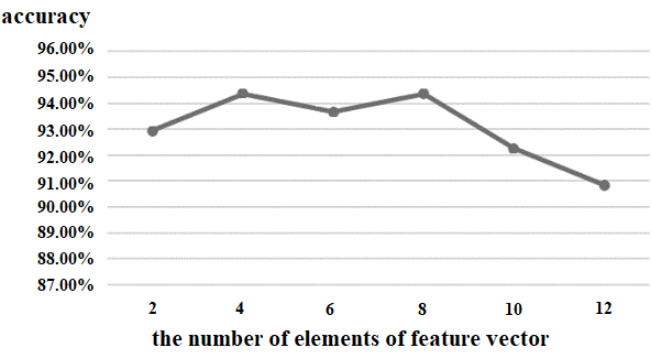
Figure 10. Comparison of the number of elements of the feature vector.